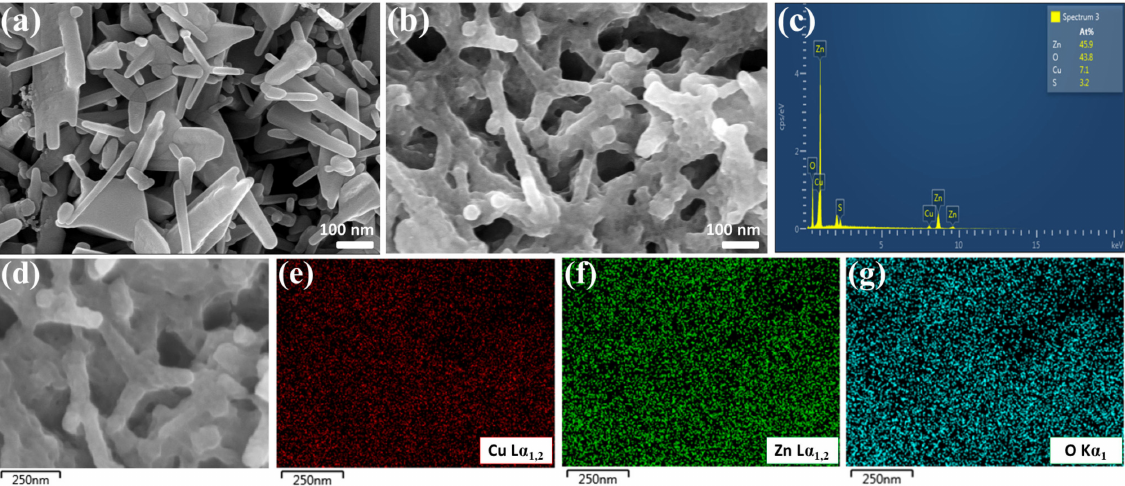
Figure 1. FESEM morphologies of ZnO-T electrode ( a ) before and ( b ) after CuO modified; ( c ) EDS spectrum of CuO/ZnO/FTO electrode; ( e – g ) elemental maps of Cu, Zn and O in the CuO/ZnO/FTO electrode from the corresponding region of image ( d